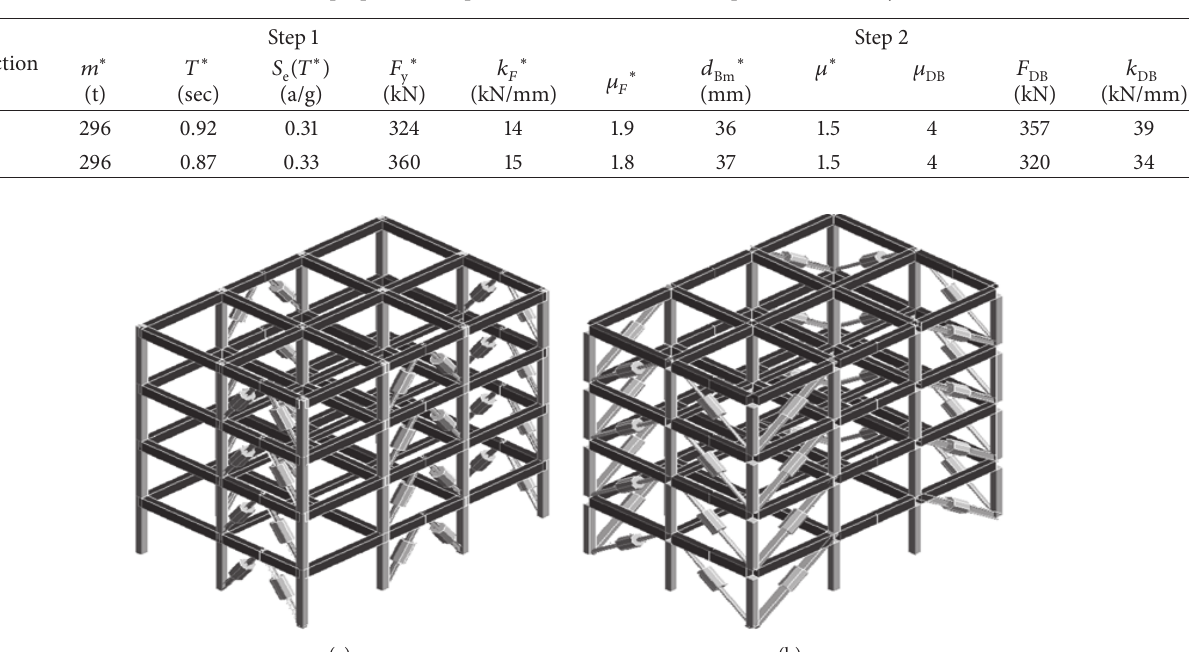
Table 3: Main properties of equivalent bare structure and equivalent braced system.